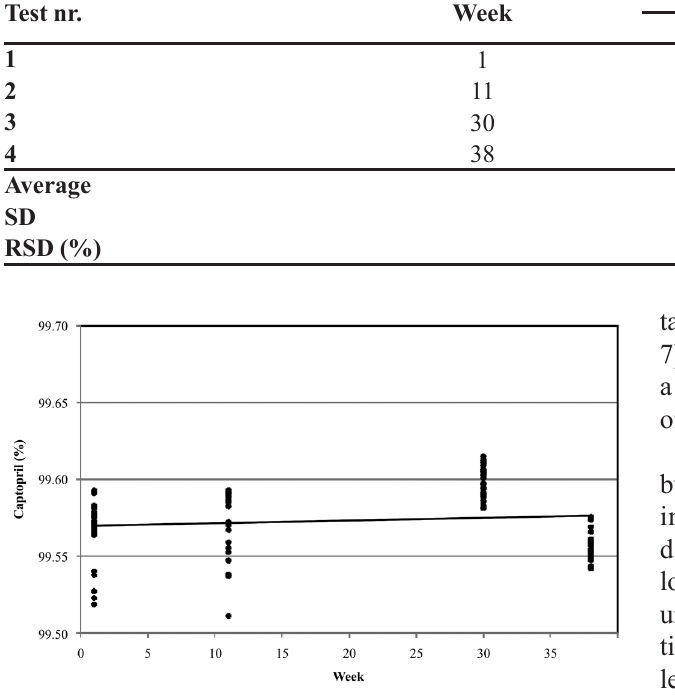
TABLE V - Related substances results for long-term stability evaluation Test nr.